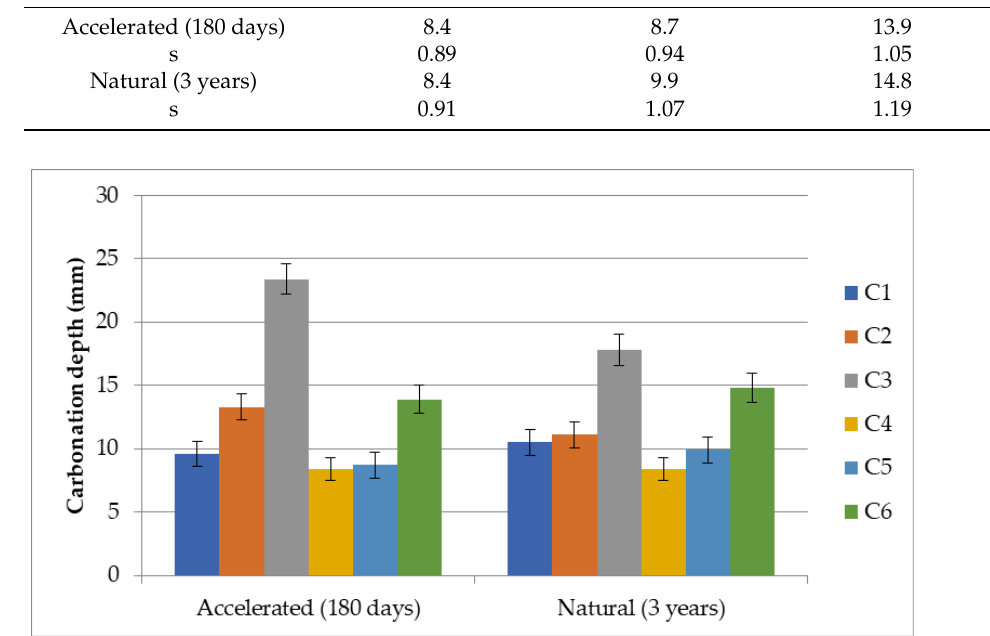
Figure 11. Accelerated and natural carbonation depth of all tested concrete